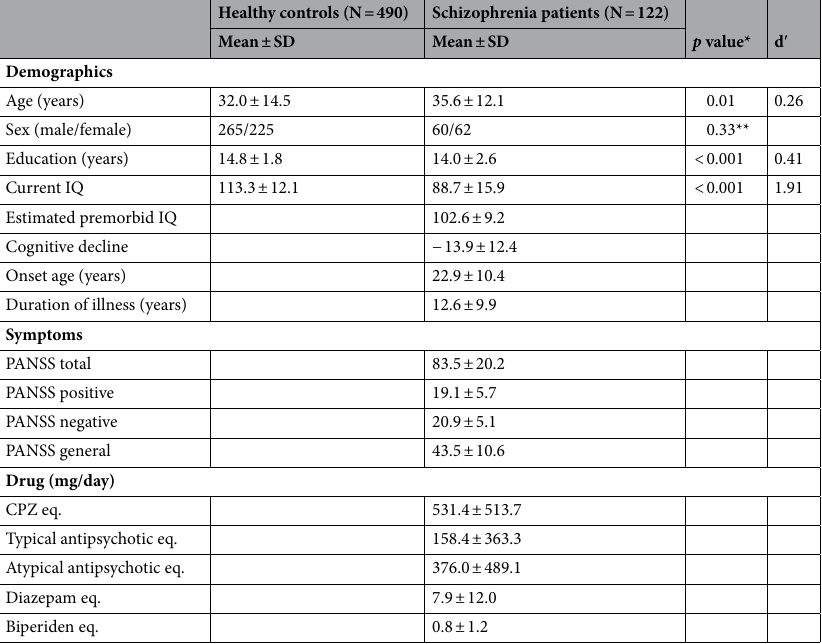
Table 1. Demographic and clinical characteristics of HCs and SZs. *Based on t -test except for Sex, ** χ 2 -test. PANSS Positive and Negative Syndrome Scale, CPZ eq . chlorpromazine